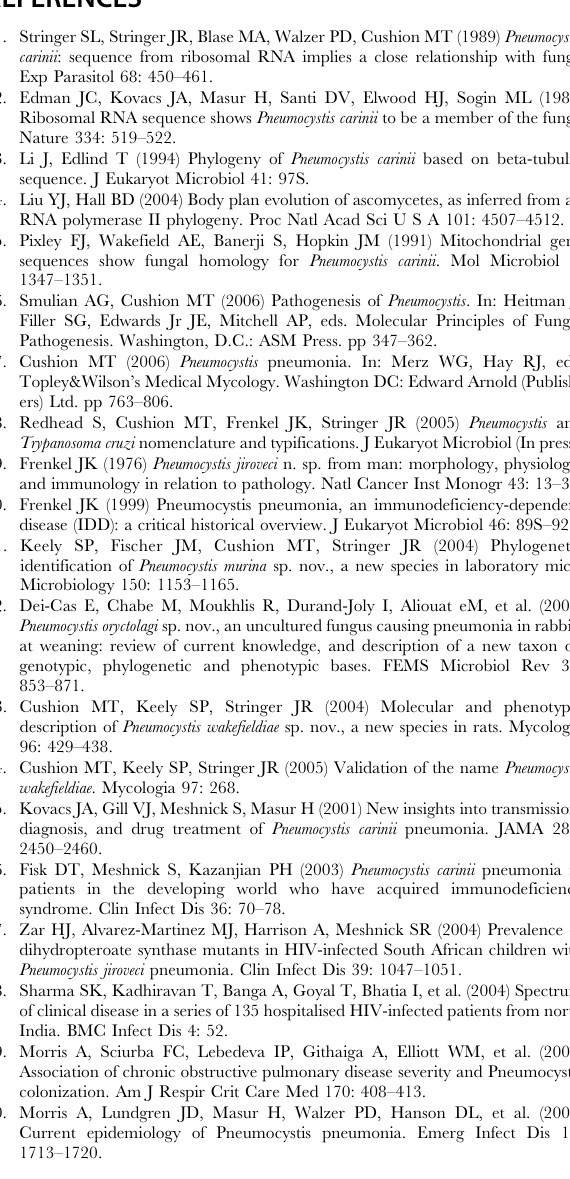
Table S2 EST BLAST2GO Molecular Function-All levels. Hierarchical distribution of the Molecular Function of the ESTs using BLAST2GO.